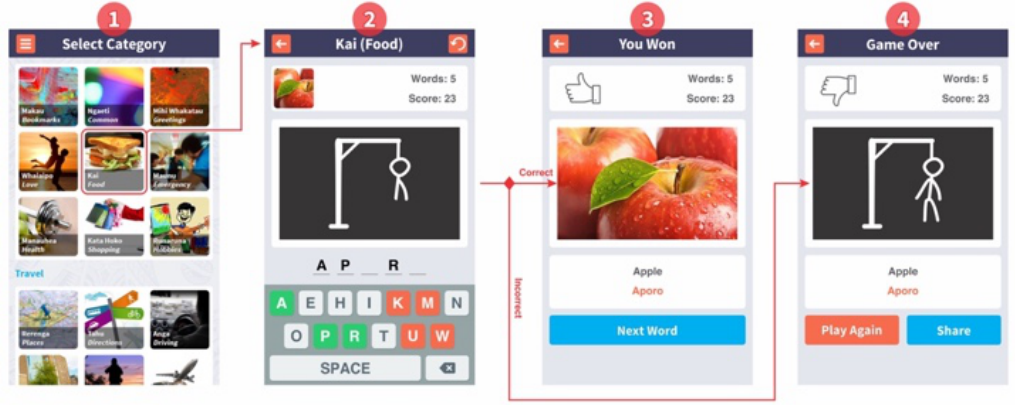
Figure 7. Learn Lingo – Flash cards app prototypical implementation of Flash cards app is shown in Figure 6. The app allows user to securely login and create various flash card sets. The set can be constructed using the data that was captured and curated using Save Lingo.